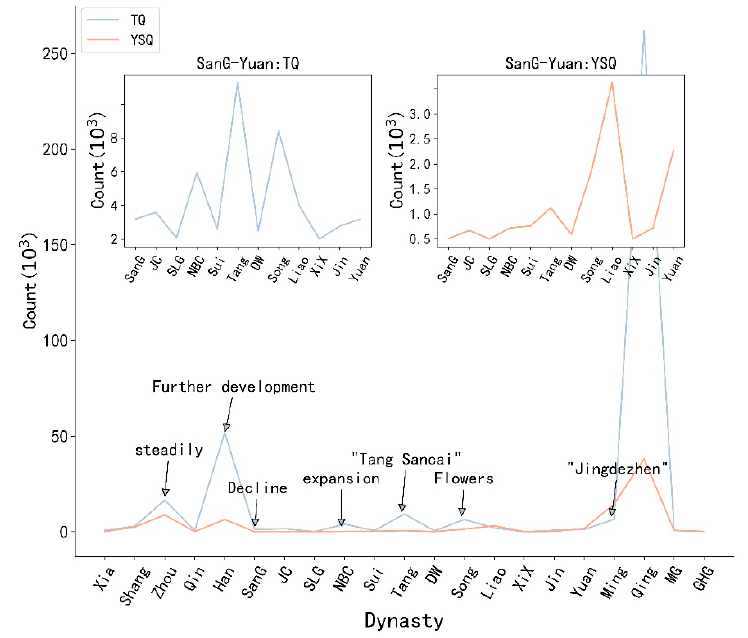
Figure 2. Vein of the “life cycle” of pottery, jade stone and gem.